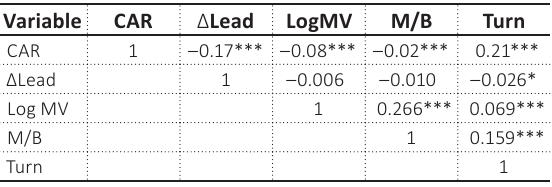
Table 1 (cont.). Descriptive statistics and correlations